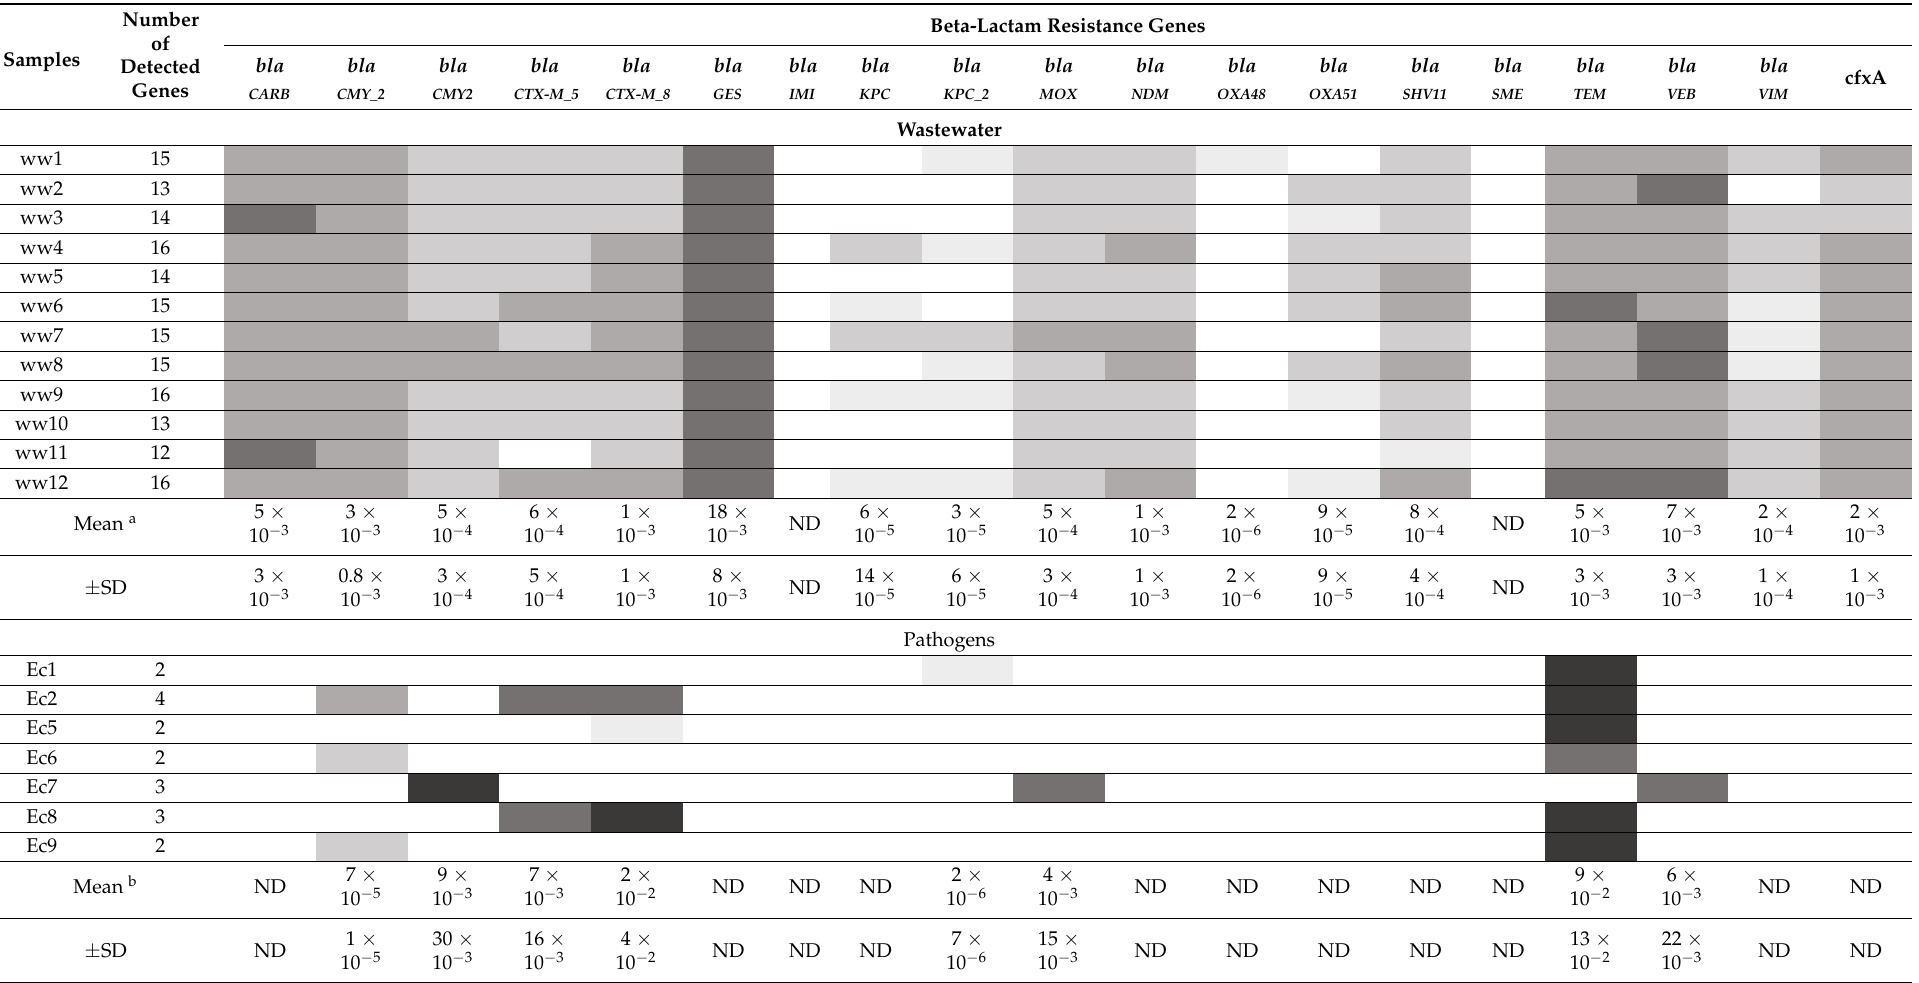
Table 2. Beta-lactam resistance genes detected in hospital wastewater and pathogens isolated from hospital